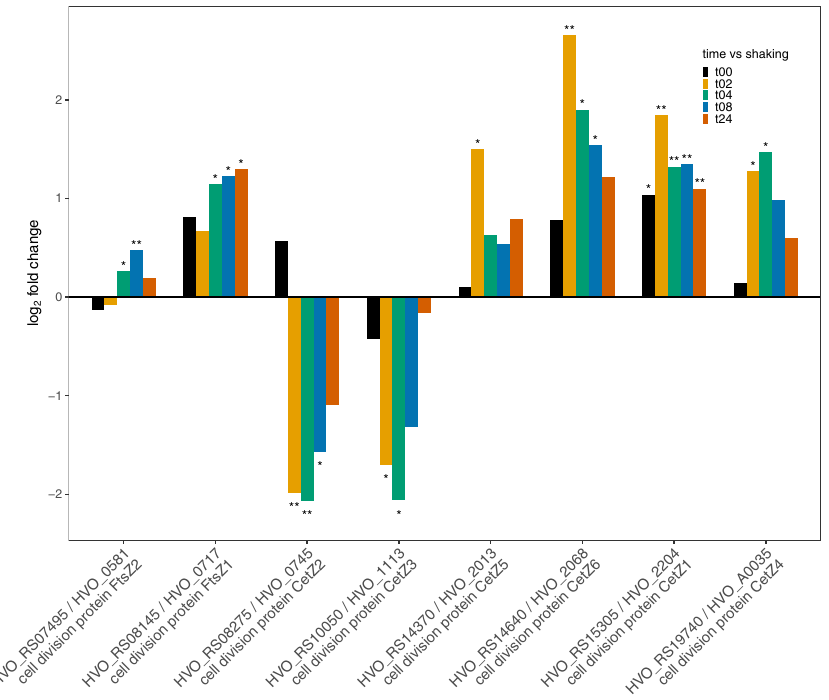
Figure 5. Bar plot depiction of differential expression compared to planktonic state for FitZ and CetZ genes; gene id on the x-axis and log 2 fold change on the y-axis, * p value < 0.05 and ** p value <